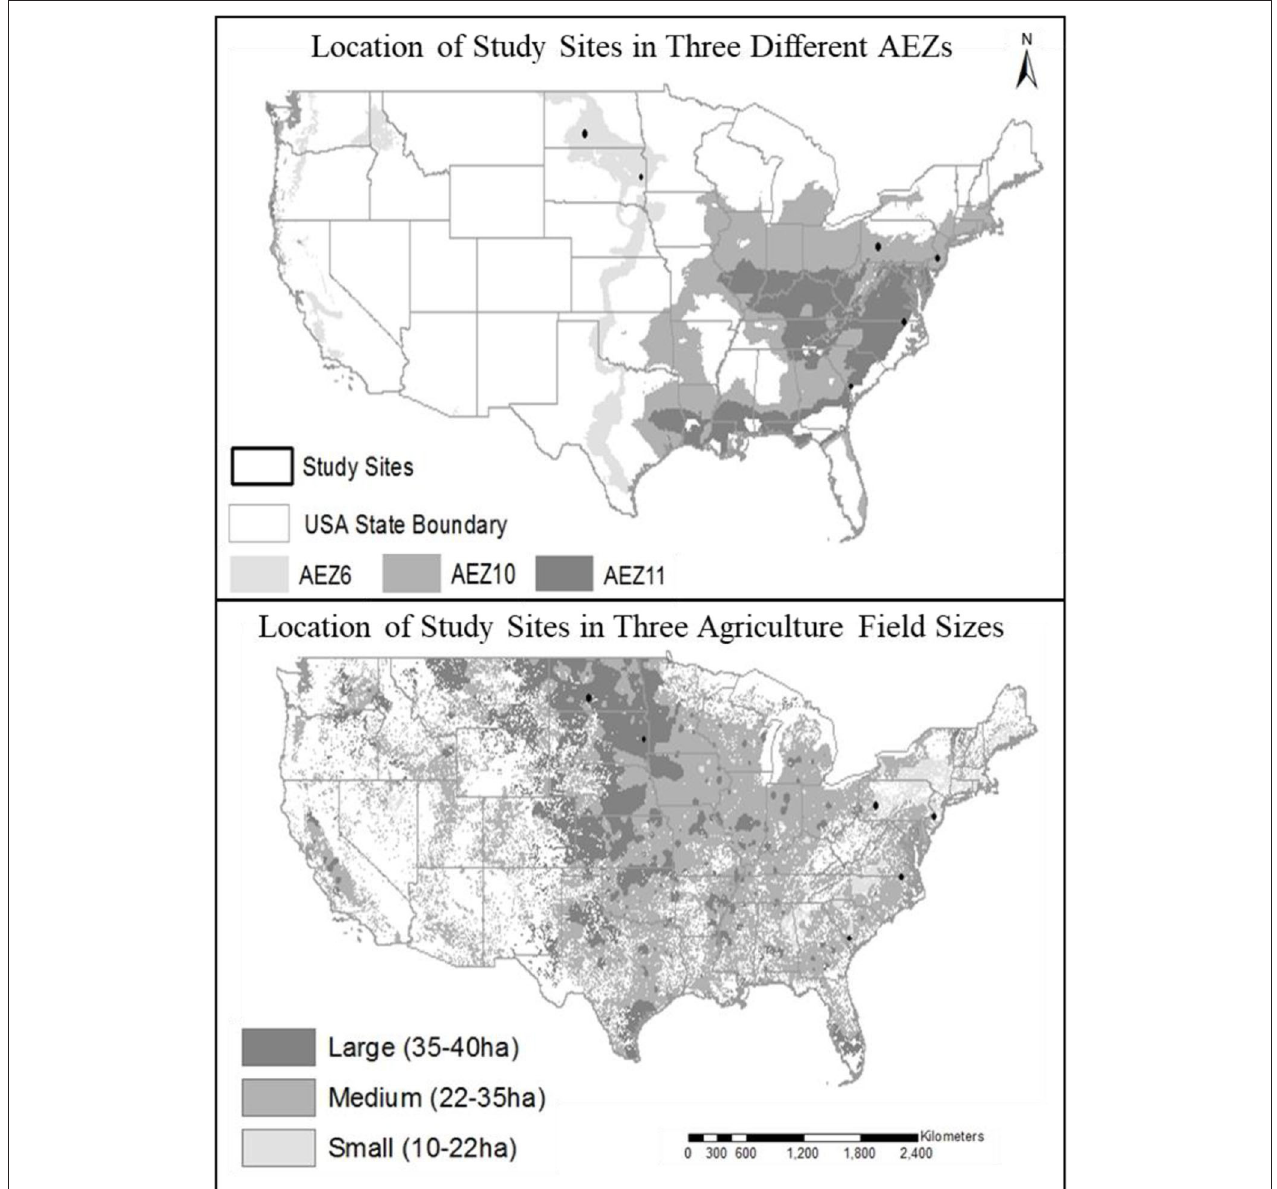
FIGURE 1 | The location of three pairs of TRaining (TR) and TEst (TE) regions selected each in three AEZs and three agriculture field